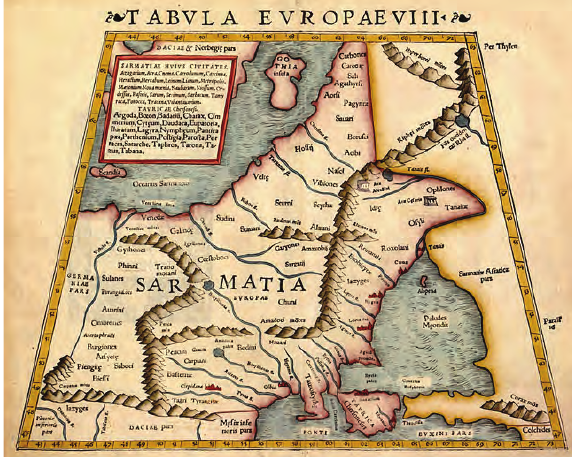
Fig. 2. Map of Europae Tabula VIII from “Atlas zur